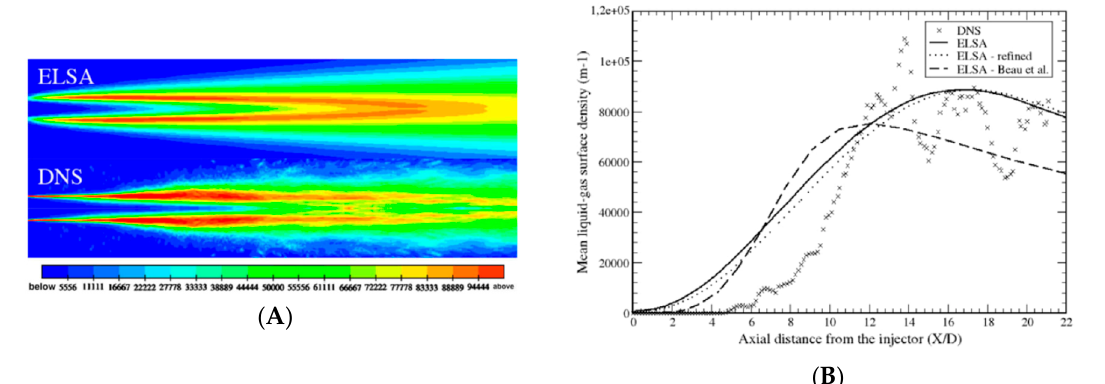
Figure 11. Result of spray simulation using ELSA model in the dense spray region [45]. ( A ) Surface density field; ( B ) Surface density profiles along the injection axis. Reproduced with permission from Elsevier.